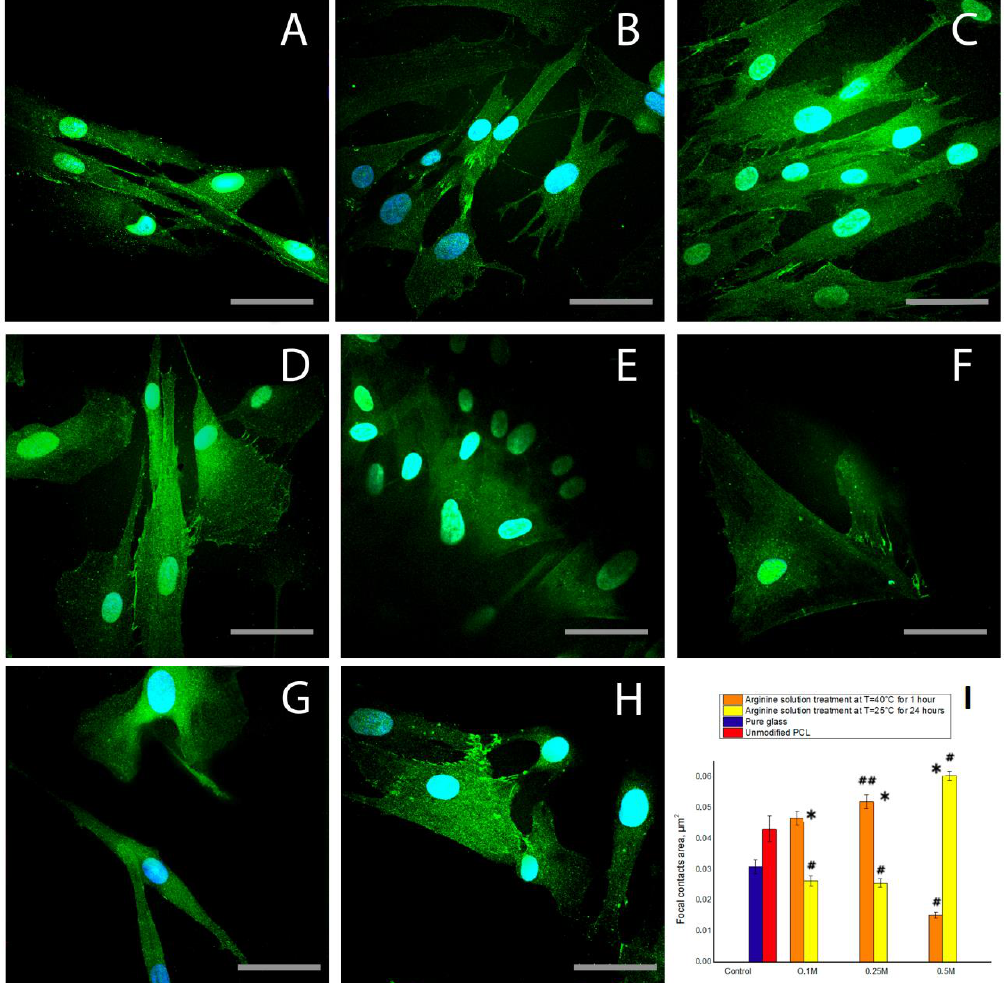
Figure 7. Presence of focal contacts of the MSC cells after 1 day of cultivation: ( A ) on the pure glass, ( B ) on the unmodified PCL, ( C ) on the film treated with the 0.1 M arginine solution for 1 h at T = 40 °C, ( D ) on the film treated with the 0.25 M arginine solution for 1 h at T = 40 °C, ( E ) on the film treated with the 0.5 M arginine solution for 1 h at T = 40 °C, ( F ) on the film treated with the 0.1 M arginine solution for 24 h at T = 25 °C, ( G ) on the film treated with the 0.25 M arginine solution for 24 h at T = 25 °C, ( H ) on the film treated with the 0.5 M arginine solution for 24 h at T = 25 °C, and ( I ) focal contacts area of the MSC cells on the modification conditions after 1 day of cultivation (n = 5: *—p < 0.01 for the same concentration data, #—p < 0.01, ##—p < 0.05 compared with the unmodified PCL). Scale bar 50 µm.